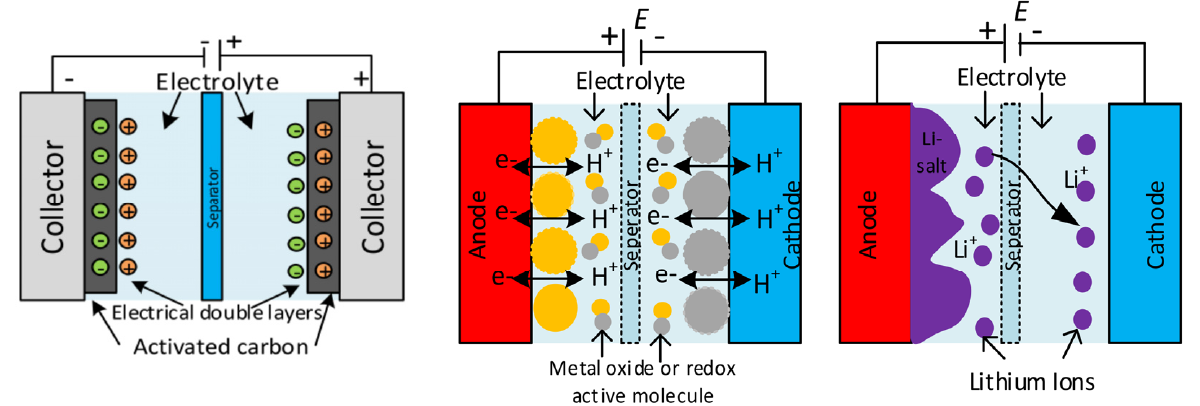
Figure 7. Configurations of supercapacitors; a common supercapacitor, a pseudocapacitor and a hybrid supercapacitor [155].